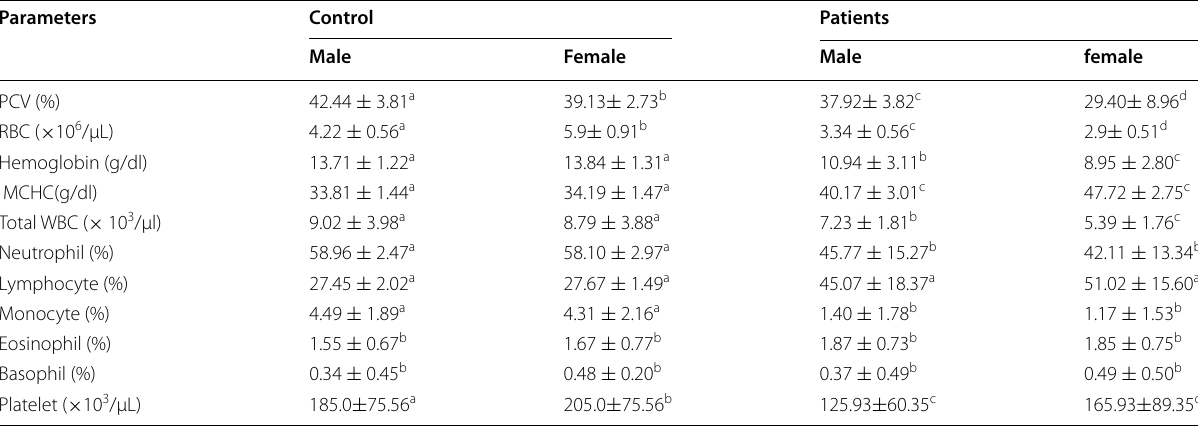
The values are expressed as mean standard deviation of the observations in each group ± Values with different superscript letters in the same row are significantly different from each other ( P